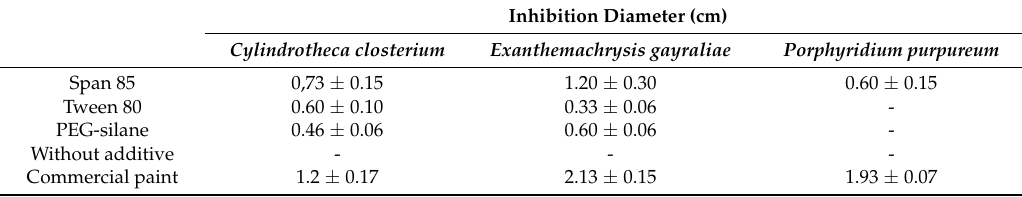
Table 2. Inhibition zone diameter of coatings against C. closterium, E. gayraliae, P. purpureum